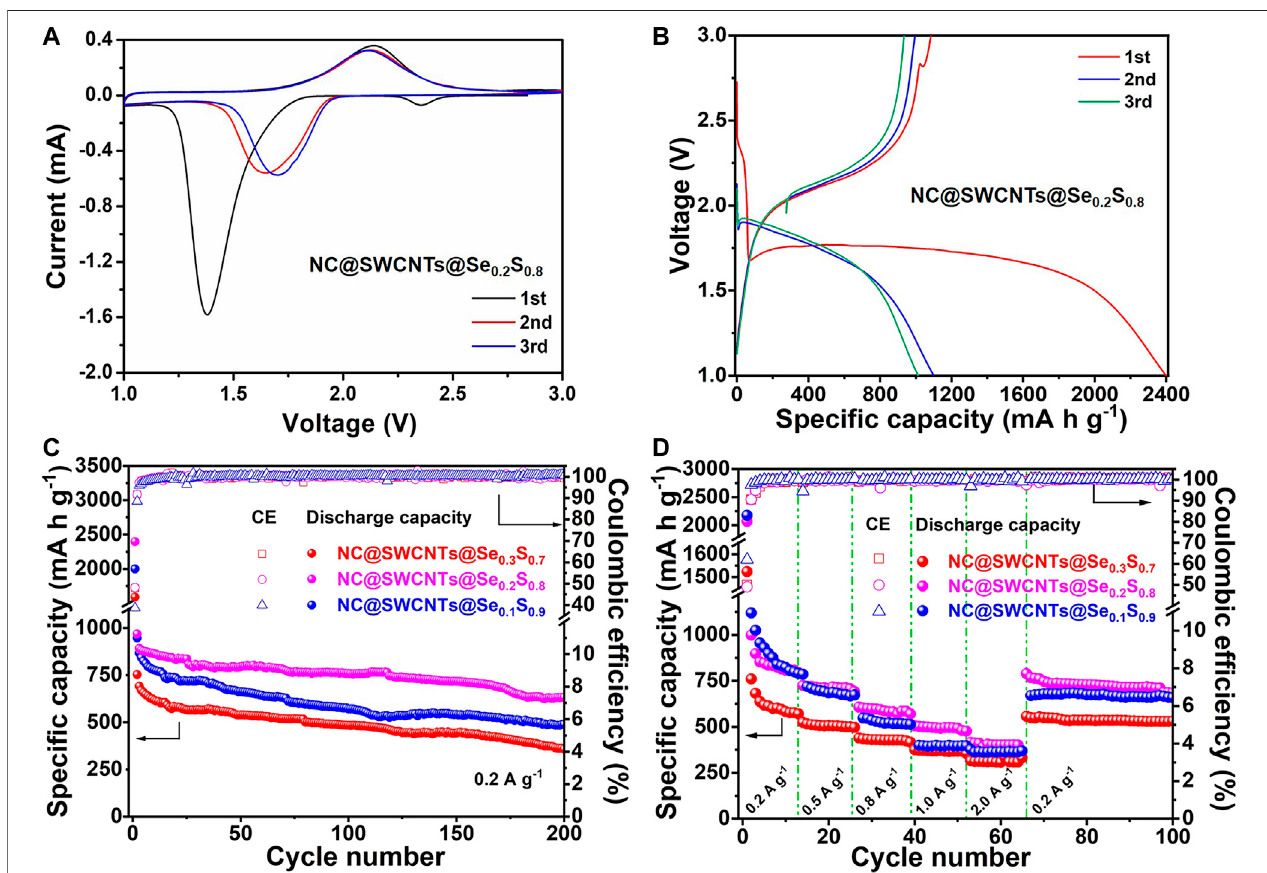
FIGURE4|(A) CV curves oftheNC@SWCNTs@Se 0.2 S 0.8 cathode. (B) Charge/dischargecurves oftheNC@SWCNTs@Se 0.2 S 0.8 cathode at 0.2 Ag − 1 . (C) Cycle performances and (D) rate performances of NC@SWCNTs@Se 1- x S x